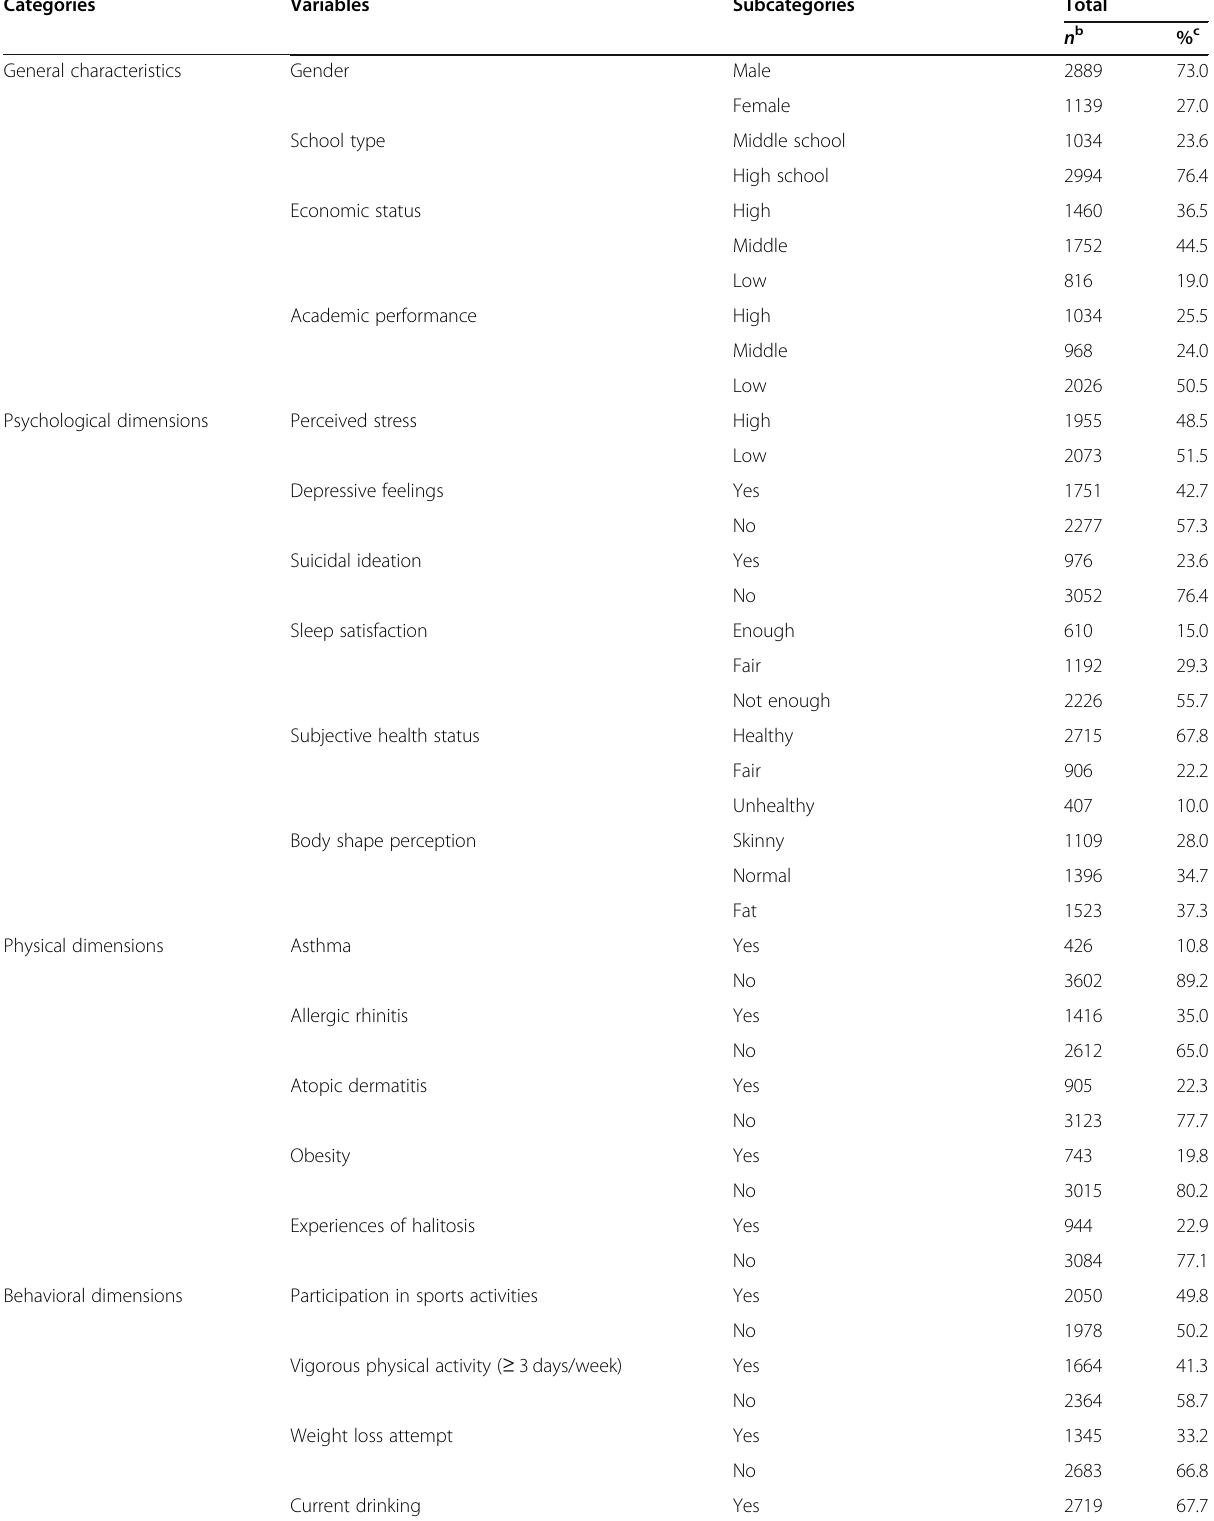
Table 1 Sample characteristics ( N =